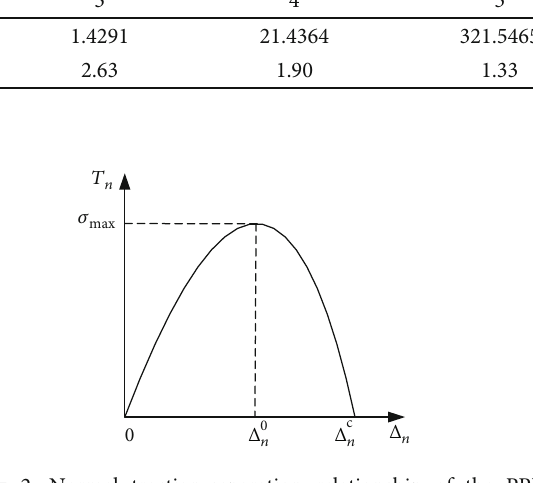
Figure 2: Normal traction-separation relationship of the PPR model in pure mode I [40].